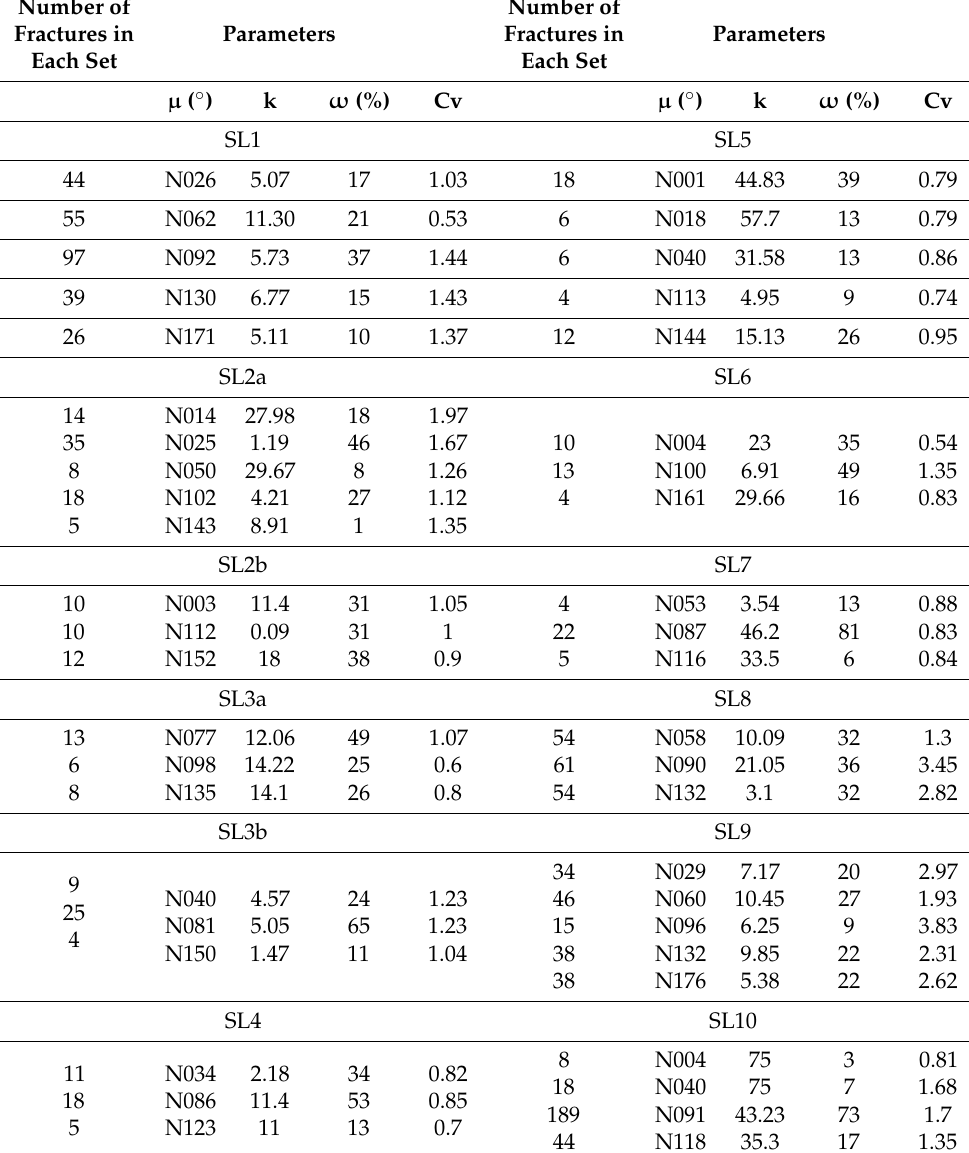
Table 2. Output parameters obtained from the MvM distribution fitting to fracture orientation data. Each scanline dataset was analyzed separately. Each simulation provides the number of fracture sets with their corresponding mean orientation µ ( ◦ ), kappa ( κ ) which corresponds to the orientation variance around the mean, and weight ( ω ) corresponding to the proportion of each fracture set. Cv: Coefficient of variability. Number of Number of Fractures in Parameters Fractures in Each Set Each Set